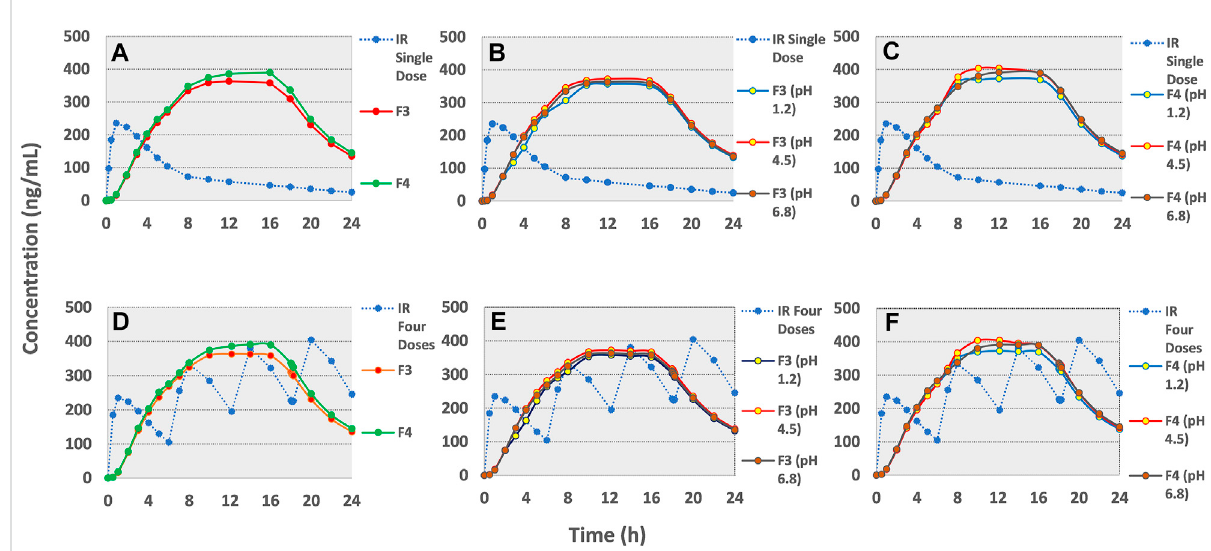
FIGURE 7 GastroPlus ™ simulated drugplasma concentration-timepro fi lesof (A) single doseIRtramadolHCl- 50 mgandoncedaily F3and F4tramadol- 190 mg osmotic tablets. Simulated pro fi les for effect of pH of dissolution media (B) on F3 and (C) on F4. Simulated pro fi le of multiple dose (q6h for 24 h) IR tramadol HCl – 50 mg and F3 and F4 (D) and in variable pH (E) for F3 and (F)